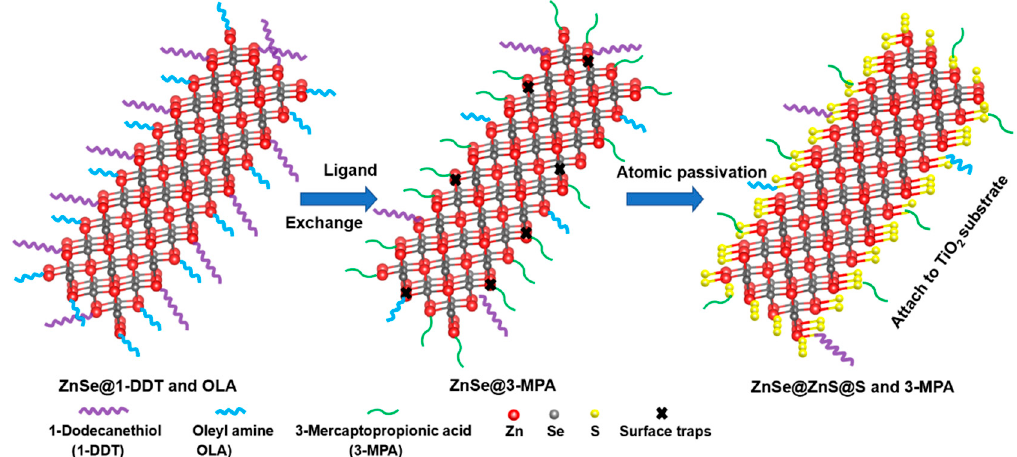
Figure 2. Schematic illustration of the surface configuration of ZnSe NRs during the 3-MPA ligand exchange and the subsequent atomic sulfur passivation by Na 2 S.